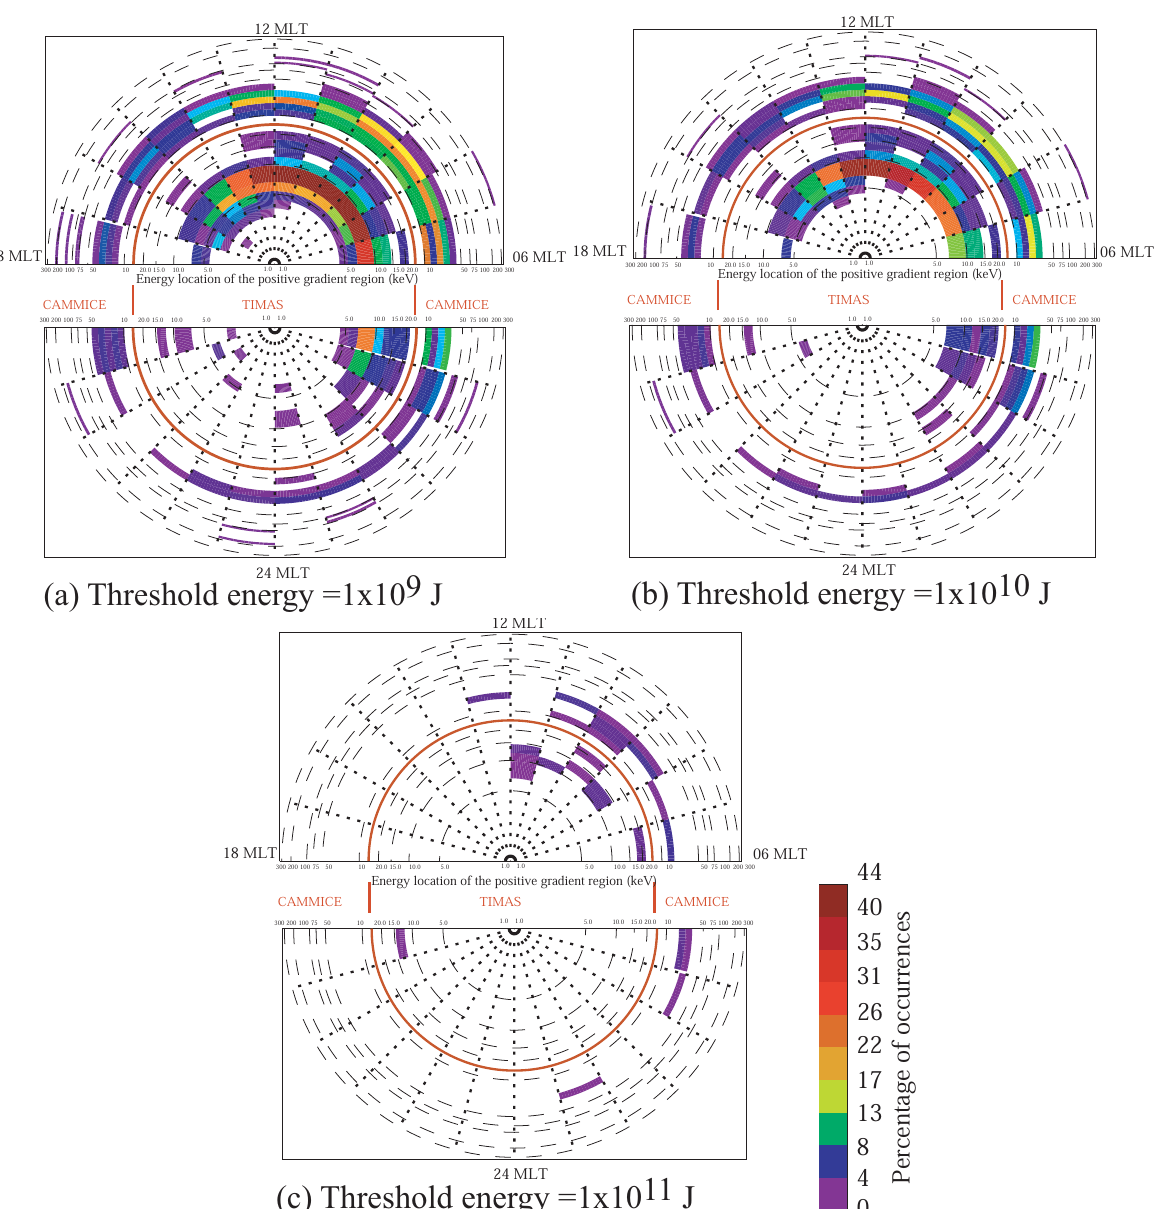
Fig. 7. As for Fig. 6, but with a total free energy threshold applied at ( a ) 1 × 10 9 J, ( b ) 1 × 10 10 J and ( c ) 1 × 10 11 J. This has the effect of reducing the occurrences at higher particle Figure 7. Figure 7. Figure 7.